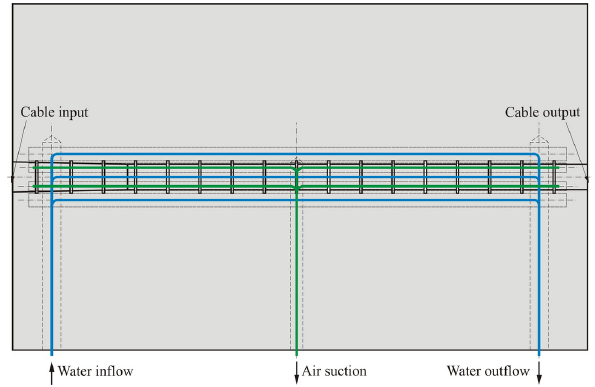
Figure 5: Kinematic diagram of water circulation installation in a pressure calibrator.